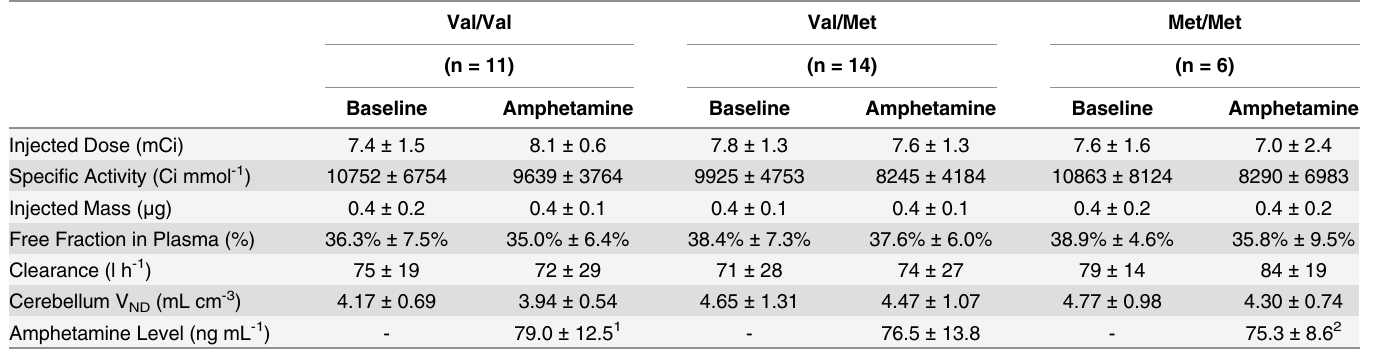
Table 2. [ 11 C]FLB 457 baseline and post-amphetamine scan